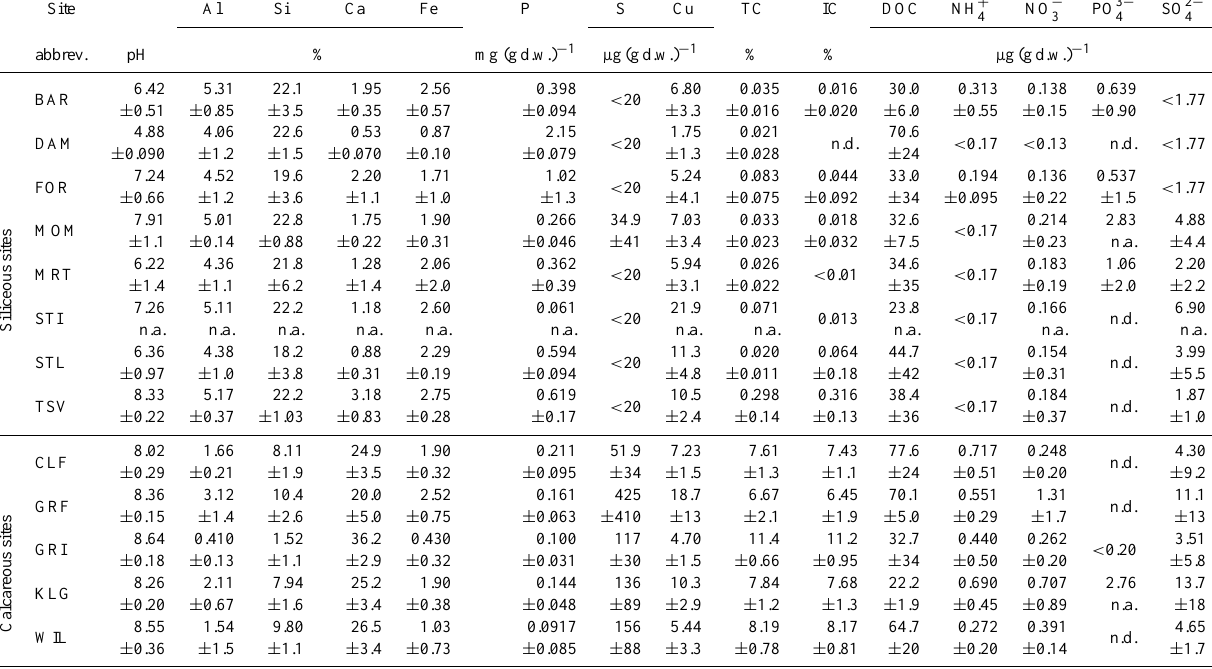
Table 3. Site mean of measured chemical parameters for each glacier forefield. Values are reported with ± 2sd, which reflects the variance within the site. Organic carbon is not reported, as the difference between TC and IC was below the sd of individual sample replicates.